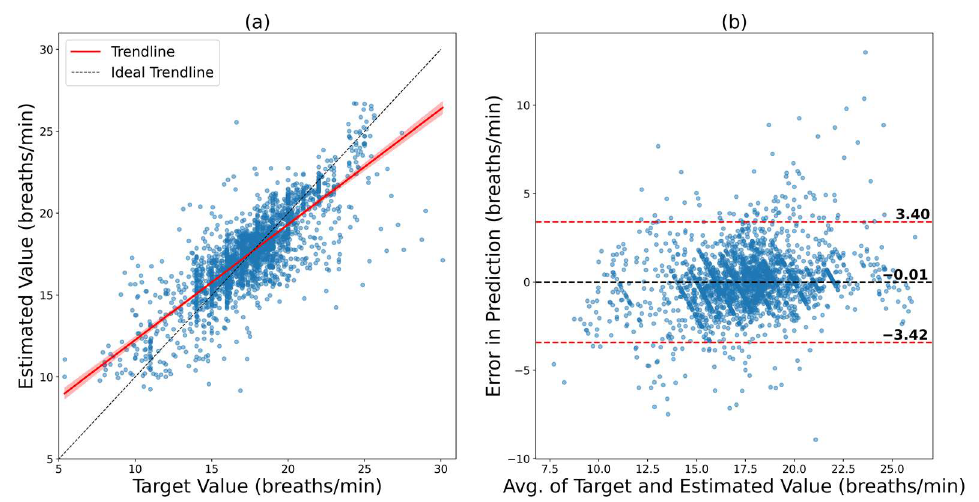
Figure 7. Results of ConvMixer, which was trained on VORTAL and later fine-tuned on the BIDMC dataset. ( a ) Regression plot that shows how close the trendline is to the ideal trendline. ( b ) Bland– Altman plot that shows the 95% confidence interval of the error.